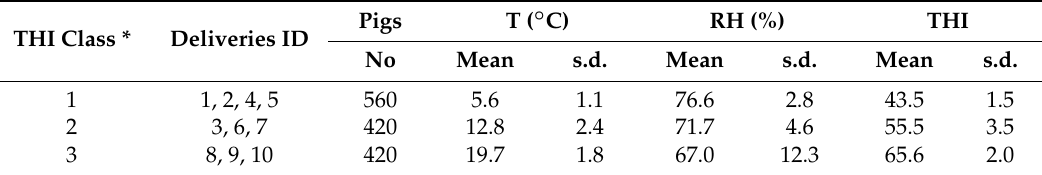
Table 2. Distribution based on the Temperature Humidity Index (THI) of the ten deliveries of Italian heavy pigs transported approximately for 30 min under commercial conditions. For each class of THI, identification (ID) of the deliveries, number of pigs, mean and standard deviation (s.d.) of outdoor temperature (T), relative humidity (RH) and THI at unloading are shown.